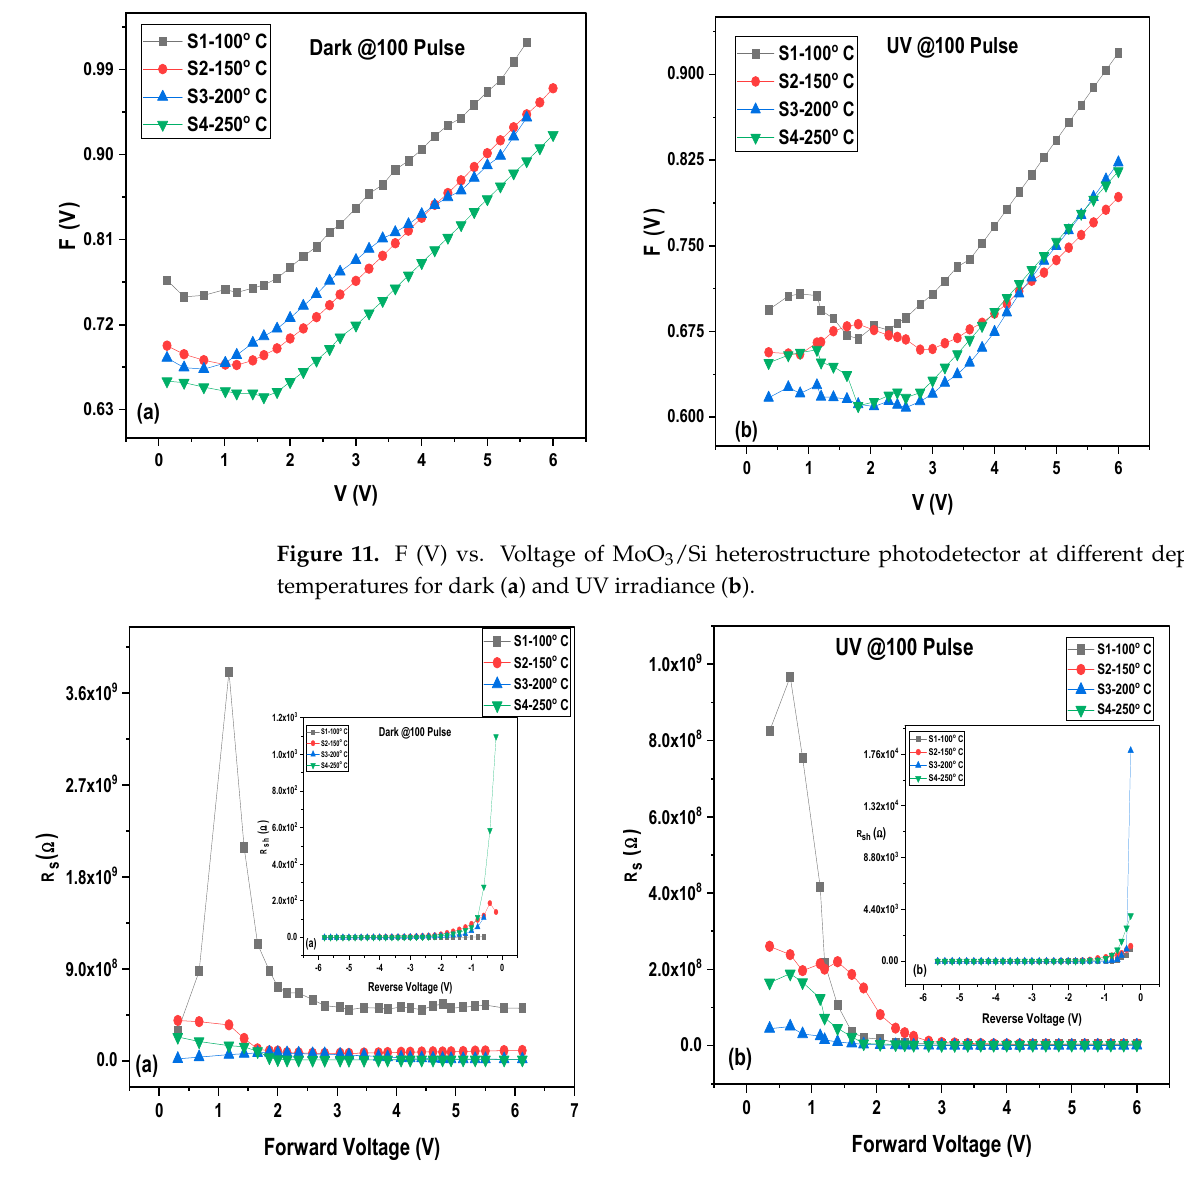
Subsequently, at a negative bias voltage, the value of R i becomes constant for all thicknesses that correspond to R sh . The transportation of charge carriers through the diffusion layer or the enhanced tunneling current through the barrier high using heavy-doped n -type Si can cause a lower value for the series resistance R s [53].